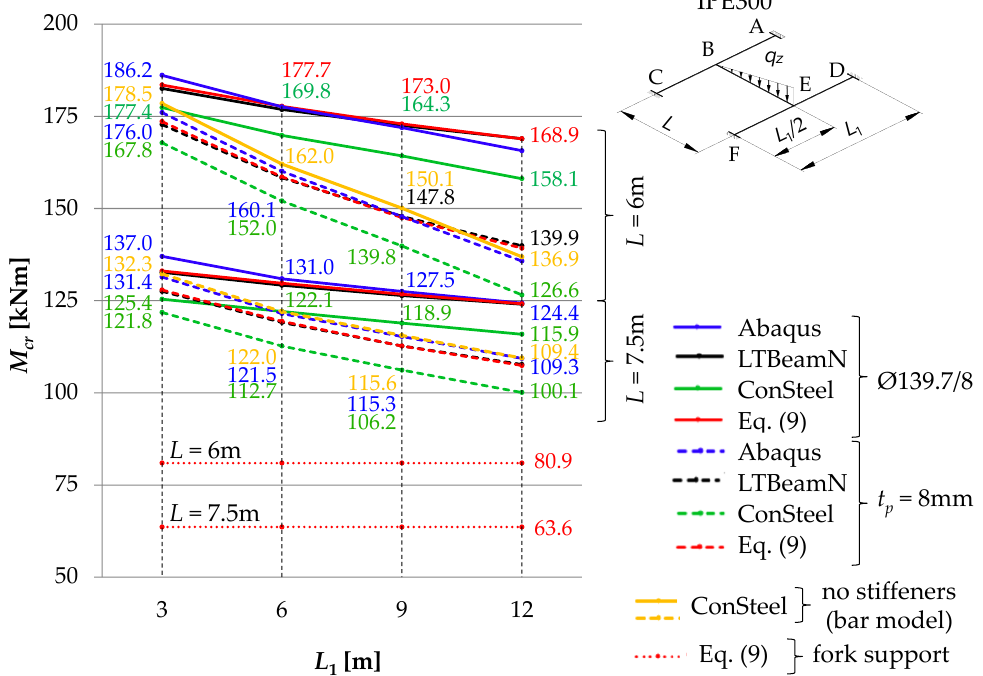
Figure 12. M cr of the critical (main) beam B – E with triangular load as a function of the span L 1 of the supporting beams A – C and D – F.